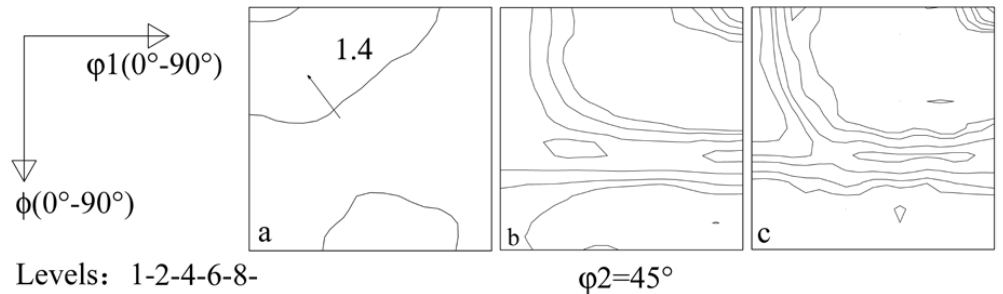
Figure 6. Measured textures of a Fe-0.46wt%Si steel. ( a ) Prior to rolling; ( b ) 52% reduction; ( c ) 80% reduction.